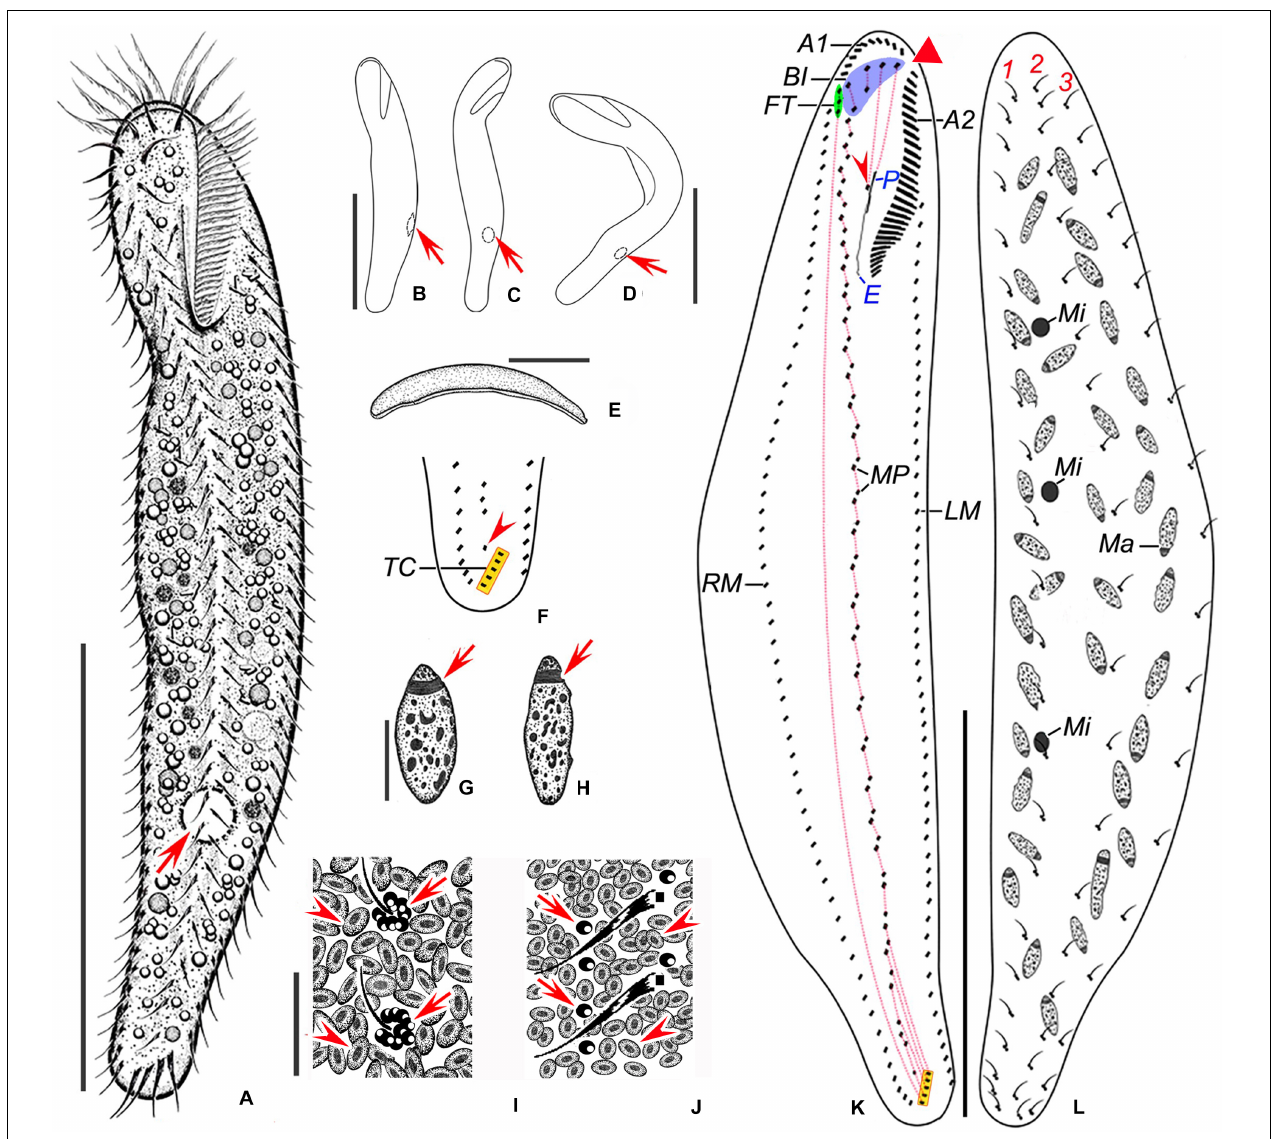
FIGURE 1 | Nothoholosticha luporinii n. sp. from life (A–E,I,J) and after protargol impregnation (F–H,K,L) . (A) Ventral view of a representative individual, arrow marks the contractile vacuole. (B–D) Overviews, showing the body flexibility, arrows mark contractile vacuoles. (E) Lateral overview. (F) Detail of the posterior body region, showing the single pretransverse cirrus (arrowhead) and transverse cirri (yellow rectangle). (G,H) Macronuclear nodules, arrows indicate replication bands. (I,J) Dorsal (I) and ventral (J) surface views, showing the arrangement of cortical granules, arrowheads denote the larger cortical granules, arrows point the smaller ones. (K,L) Ventral (K) and dorsal (L) views of the holotype specimen, showing the ciliary pattern and the nuclear apparatus. Red triangle in (K) marks the conspicuous gap between two parts of the adoral zone of membranelles, arrowhead marks the buccal cirrus, yellow rectangle delimits transverse cirri. Frontal-ventral-transverse cirri originating from the same anlagen are connected by dotted lines. A1 and A2, crown and lapel adoral membranelles; BI, bicorona; E, endoral membrane; FT, frontoterminal cirri; LM, left marginal cirral row; Ma, macronuclear nodules; Mi, micronuclei; MP, midventral cirral pairs; P, paroral membrane; RM, right marginal cirral row; TC, transverse cirri; 1–3, dorsal kineties. Scale bars = 5 µ m (G–J) and 100 µ m (A–E,K,L)